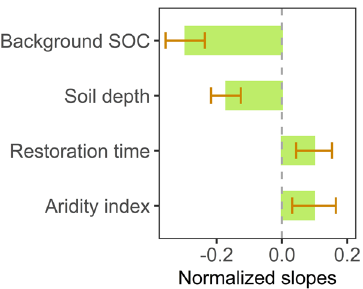
Fig. 2 Relative effects of background SOC, soil depth, restoration time, and aridity index on the difference of active versus natural carbon restoration across China. The bar graph indicates the normalized slopes with their 95% con fi dence interval (CI), because the independent variables were standardized by (observations-mean)/SD. If the 95% CI does not cover zero, it means that the difference of active versus natural restoration changes with these factors. SD standard deviation. SOC soil organic carbon.